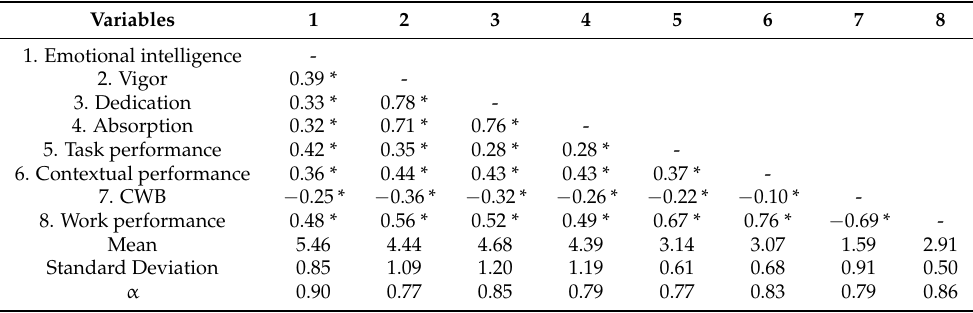
Table 1. Descriptive Statistics and Correlations between Study